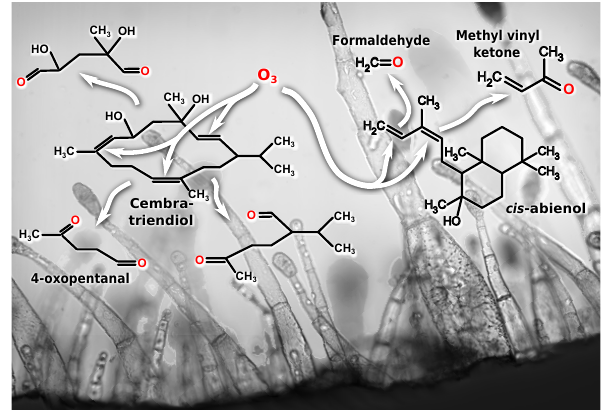
Figure 1. Ozonolysis of diterpenoids exuded by the trichomes of the investigated tobacco plants. The BYBA variety releases α - and β - cembratrien-diols (C 20 H 34 O 2 ), the Ambalema variety cis -abienol (C 20 H 34 O); the Basma Drama variety exudes all these compounds. Ozonolysis of the cembratriendiols requires at least two ozonolysis steps to form short-chained, volatile carbonyls, e.g. 4-oxopentanal (C 5 H 8 O 2 ). Ozonolysis of cis -abienol leads to the formation of volatile formaldehyde (HCHO) and methyl vinyl ketone (C 4 H 6 O). The background image shows glandular trichomes on a tobacco